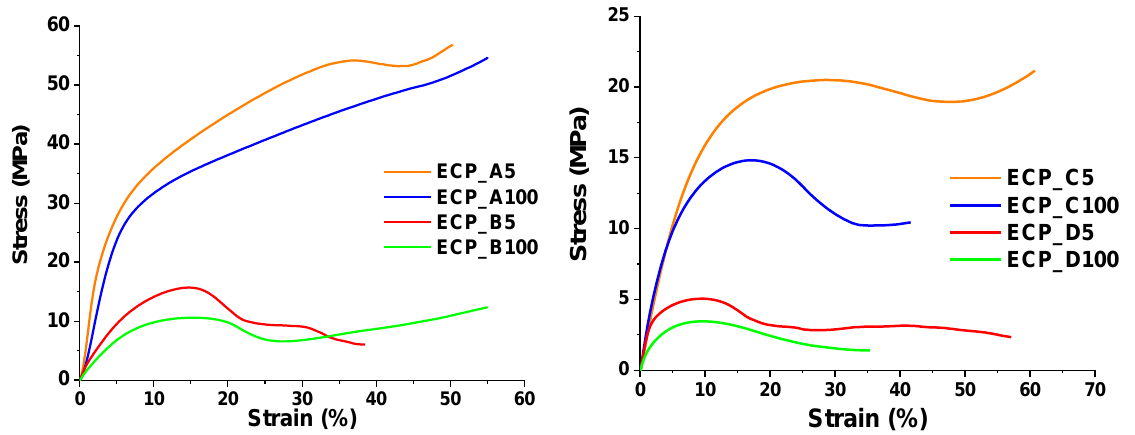
Figure 7. Compressive stress – strain profiles for composite rocket propellants. Table 7. Compressive strain–stress values of the composite rocket propellants.